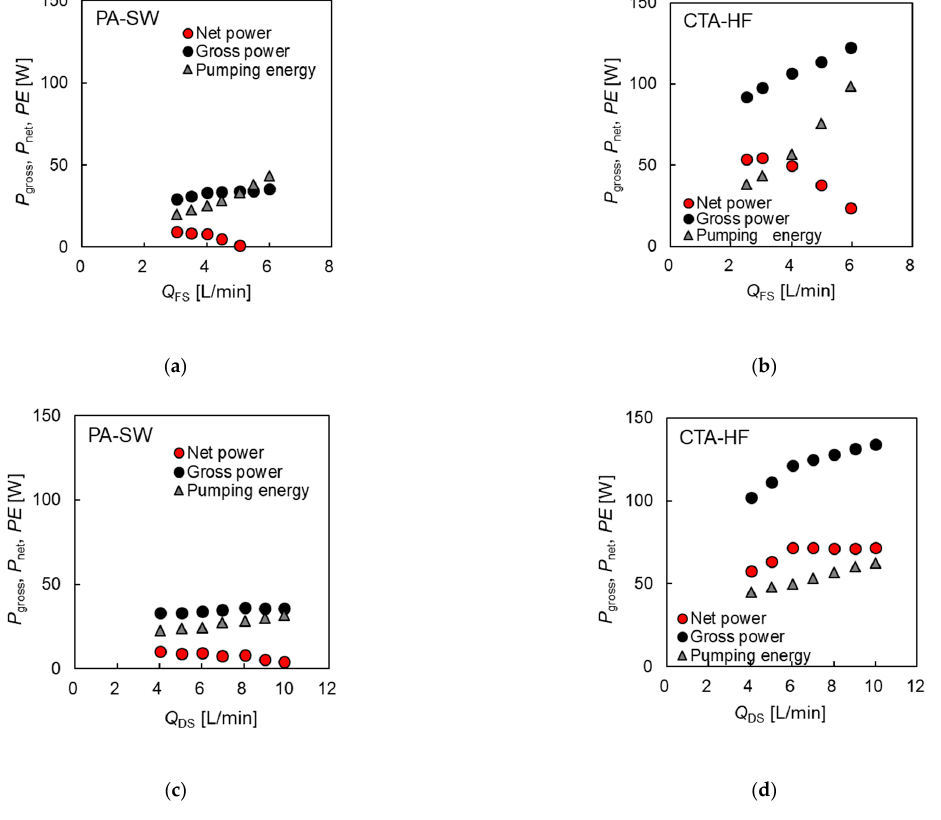
Figure 13. The gross power ( P gross ), net power ( P net ), and pumping energy ( PE ) per a module as a function of flow rates of DS and FS, using PA-SW ( a ) and ( c ) and CTA-HF ( b ) and ( d ).